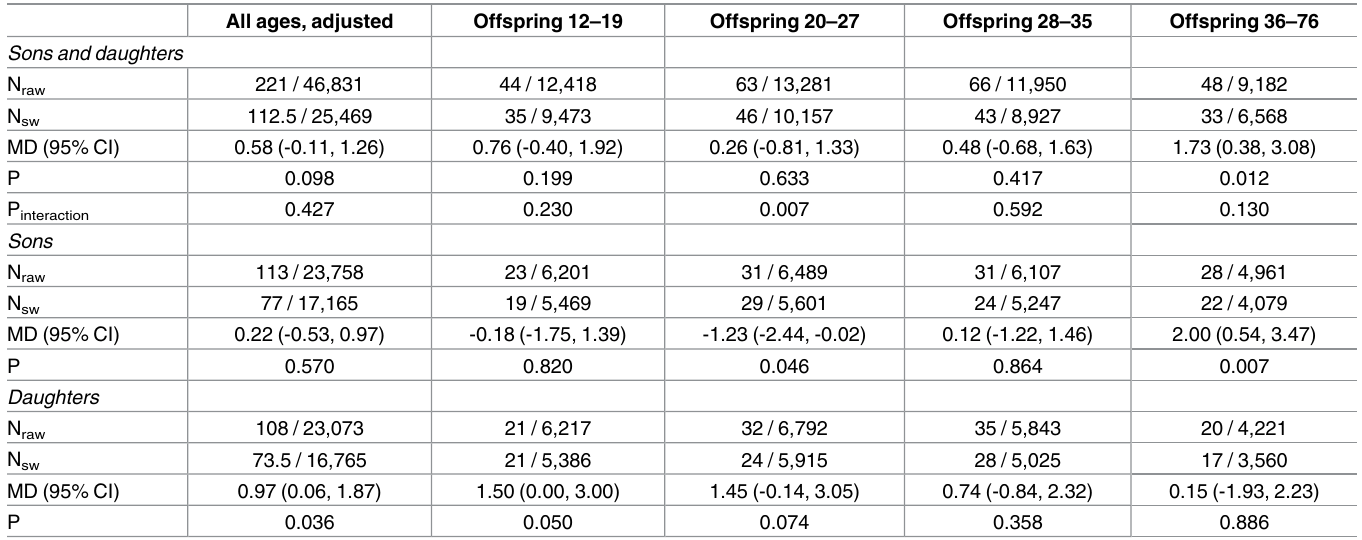
Table 3. Mean difference (95% confidence interval) in offspring BMI at various ages, if the father began smoking before 11 yearsold. All ages,